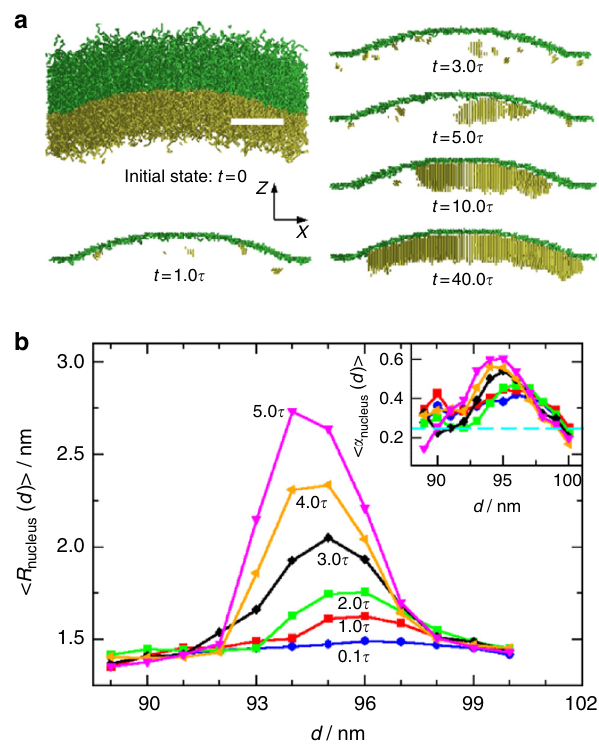
Fig. 4 Simulation study of the PLLA crystals grown near the curved liquid − liquid interface. a Snapshots of initial state for the PLLA- b -PEG chains near the curved interface and the crystallized PLLA bonds at t = 1.0 τ , 3.0 τ , 5.0 τ , 10.0 τ , and 40.0 τ . The snapshots are plotted in the range of 46 nm < y < 56 nm, where y = 51 nm is the cross-section xz plane through the droplet center. The yellow and green colors show the PLLA and PEG components correspondingly, and the green lines at different t show the position of liquid − liquid interface. b Radial distributions of average nucleus size at different time t = 0.1 τ , 1.0 τ , 2.0 τ , 3.0 τ , 4.0 τ , and 5.0 τ . Here the average is taken from 24 independent simulations, and the positions of nuclei/ crystals are determined by its center of mass (CM). Inset shows the radial distribution of average nuclei orientation at different time, with the same color coding as that in the main panel. The dashed cyan line in the inset indicates that the nuclei have no preferred orientation statistically (see Supplementary Note 2). Scale bar in a is 20